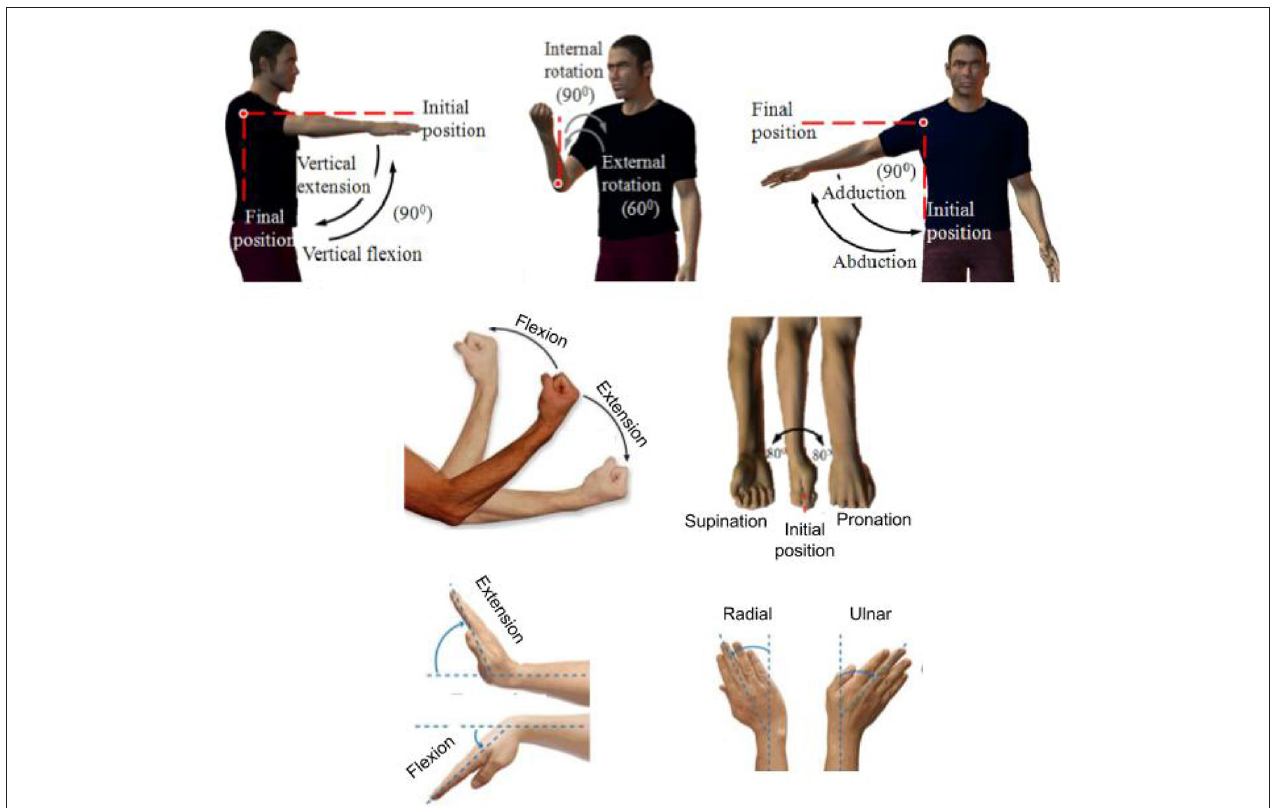
FIGURE 2 | Seven DOFs of human upper limb (excluding the hand). Adopted and modified from Gopura and Kiguchi